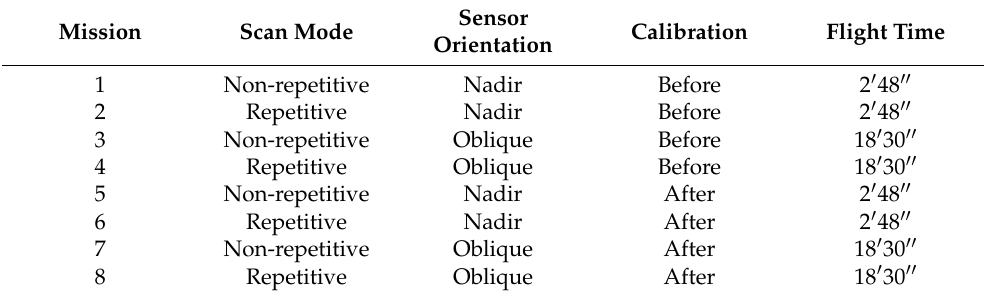
Table 2. Configuration of LiDAR missions performed on 22 October 2021 in C á diz Bay. The calibration column indicates whether the mission was performed before or after the vegetation was removed for the calibration trial. The flight time indicates the duration of the mission in minutes and